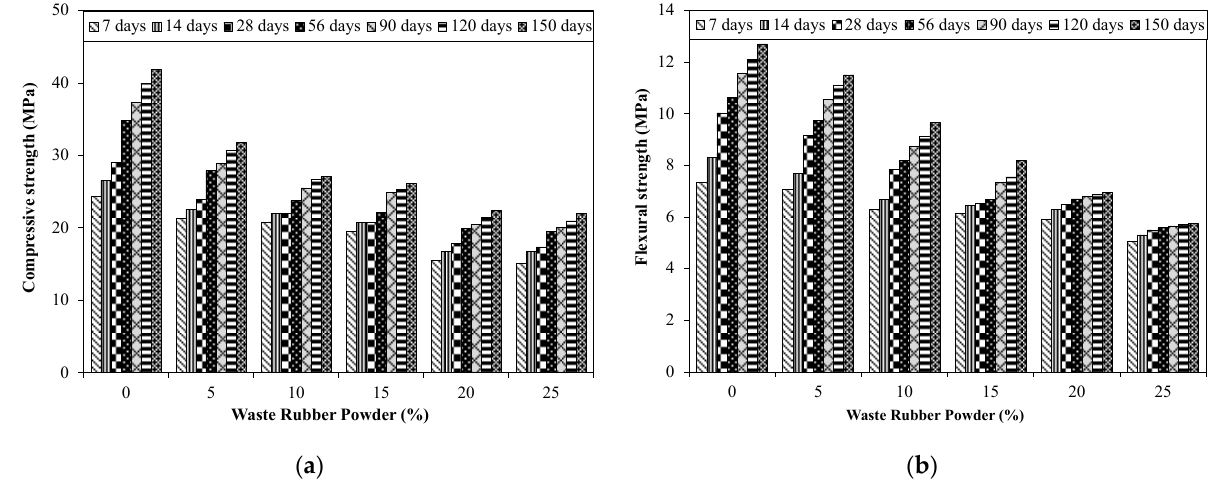
Figure 10. Effect of RW on compressive and flexural strength results. ( a ) Compressive strength; (b ) Flexural strength.